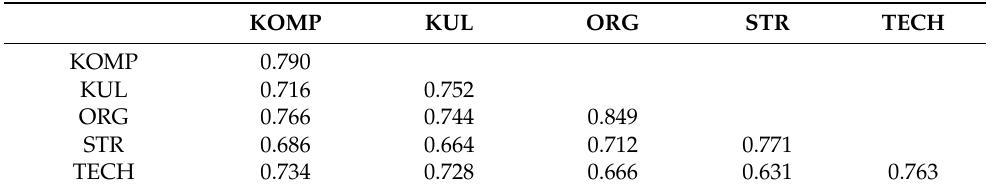
Table 4. The Fornell–Larcker criterion for discriminant validity.